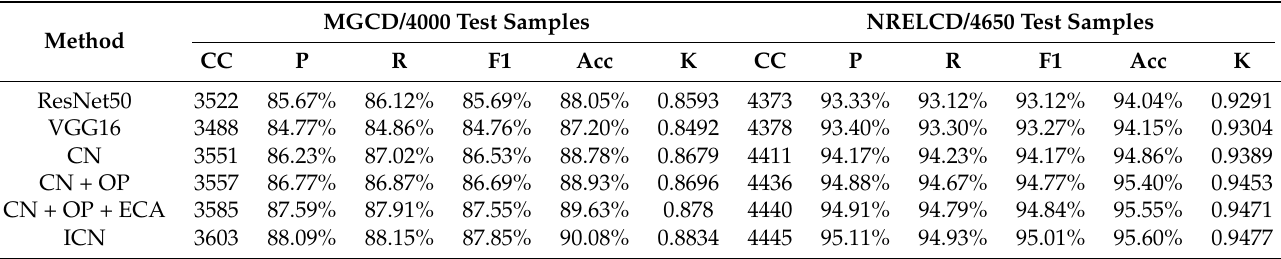
Table 2. Ablation